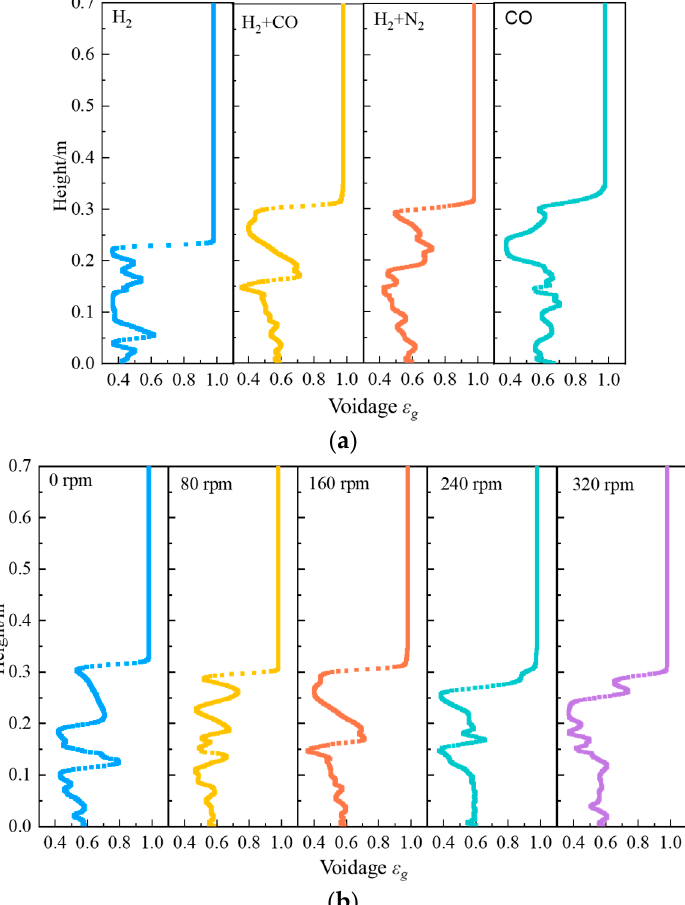
Figure 6. Axial average gas holdup of the fluidized bed. ( a ) Different gas compositions. ( b ) Different agitation speeds.